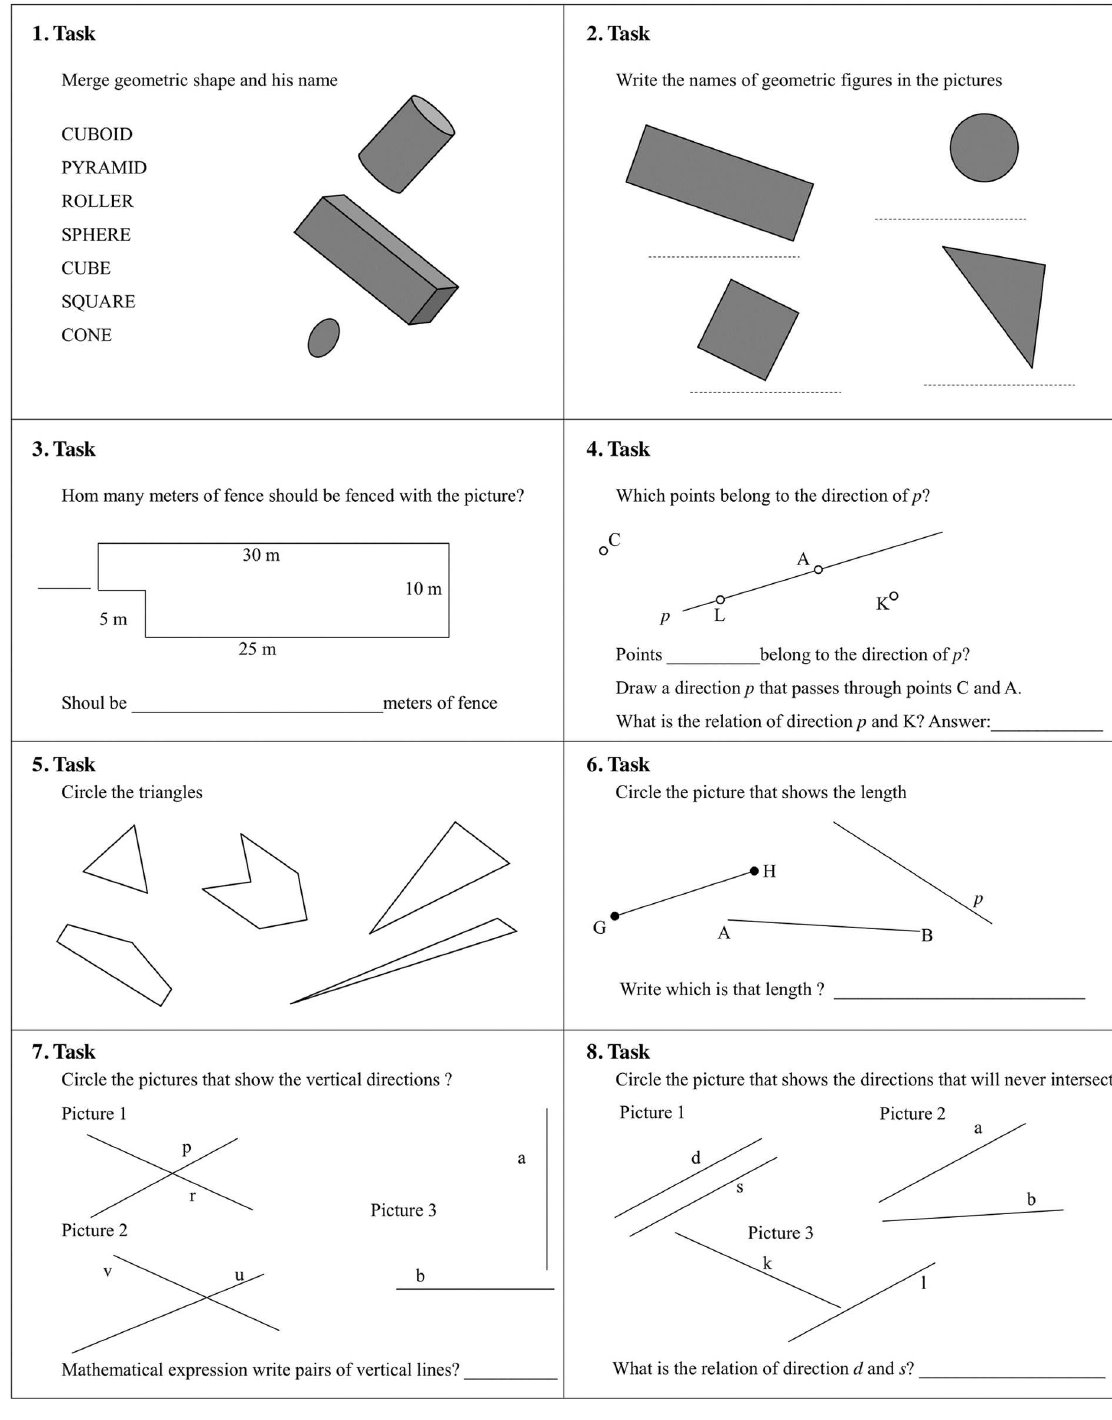
Fig 2. The geometry